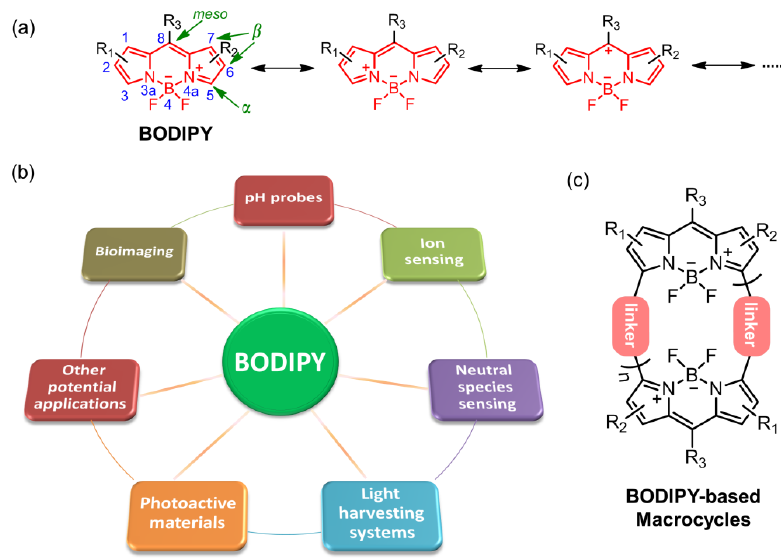
Figure 2. ( a ) Chemical structure of the boron-dipyrromethene (BODIPY) framework; ( b ) the potential applications of BODIPY derivatives; and ( c ) chemical structure of the BODIPY-based macrocycles.